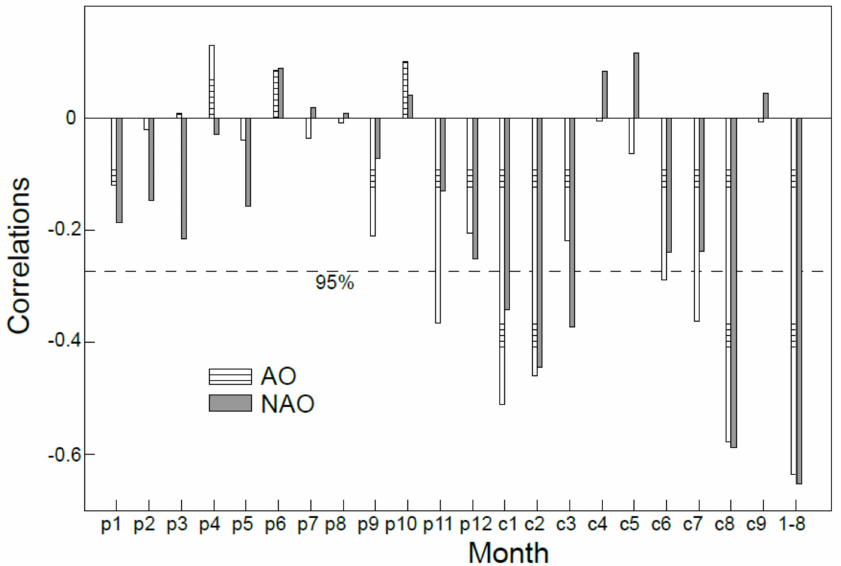
Figure 6. Correlations between tree ring oxygen isotope with NAO/AO during the period of 1950 – 1999. Numbers in the x -axis represent the months of the year, and numbers with a “p” and “c” prefix indicate the previous year and current year, respectively.